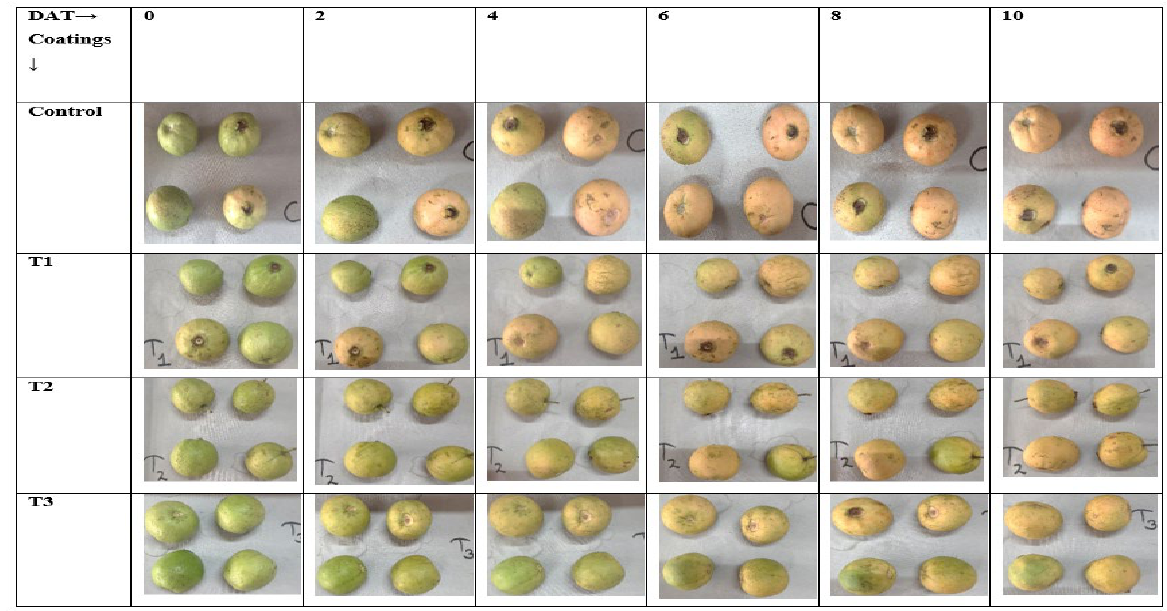
Figure 8. Effect of nanoformulations on color change of guava fruits (Hisar Surkha) during storage at 32 ± 2 °C.